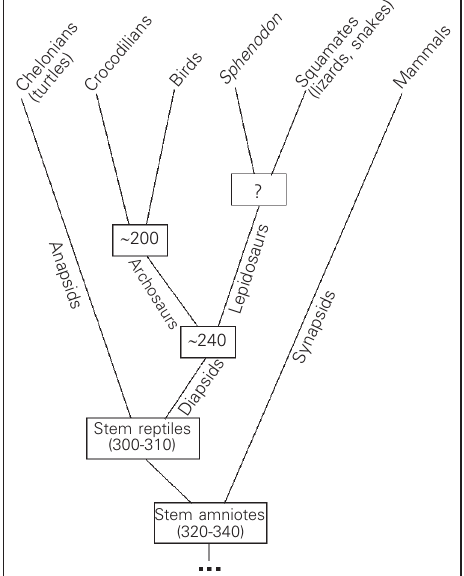
Figure 1. Simplified evolution of the amniote lineages that led to living mammals, reptiles and birds. Time in megayears. Adapted from Ref.